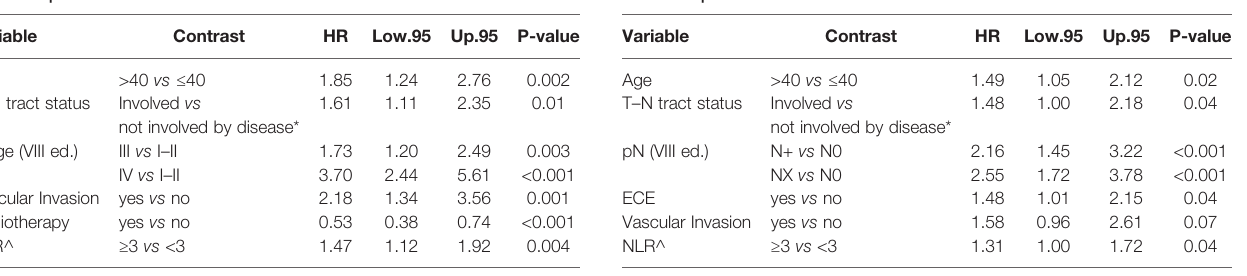
TABLE 2 | Multivariate Cox model for OS. TABLE 3 | Multivariate Cox model for